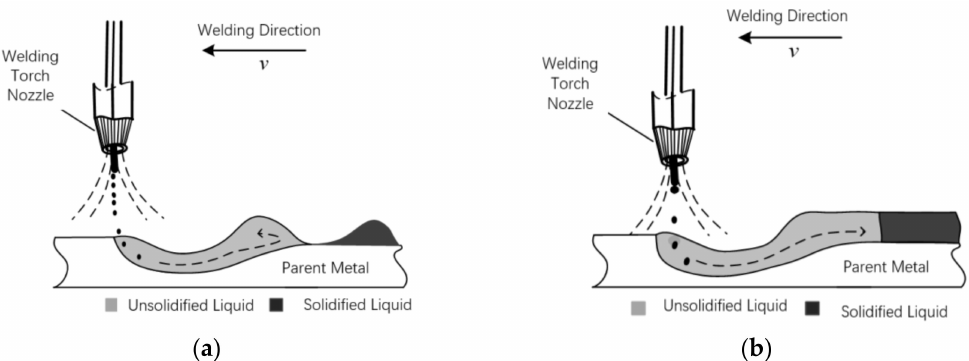
Figure 1. Schematic of the relative speeds of molten steel flows and parent material: ( a ) Low relative speed (high-speed welding); ( b ) high relative speed (normal